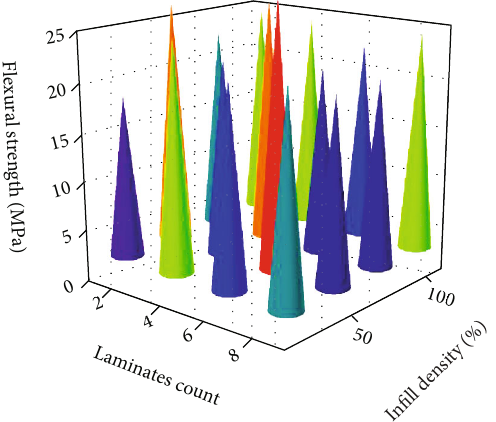
Figure 8: Flexural strength: 3D plot of laminate count and in fi ll density.